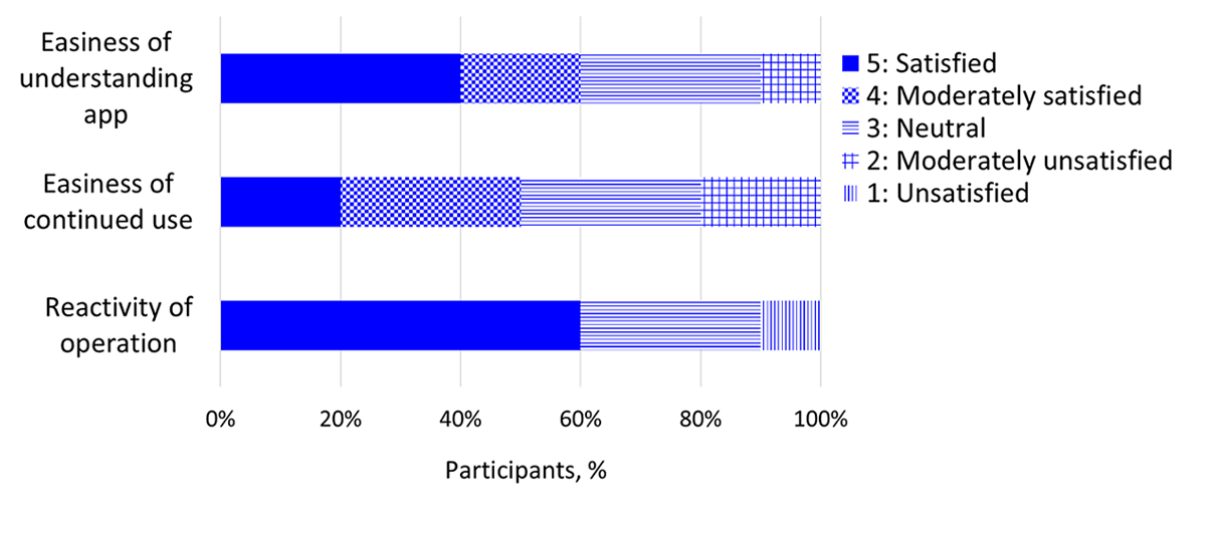
Figure 3. Participants' feedback regarding the usability of the app.